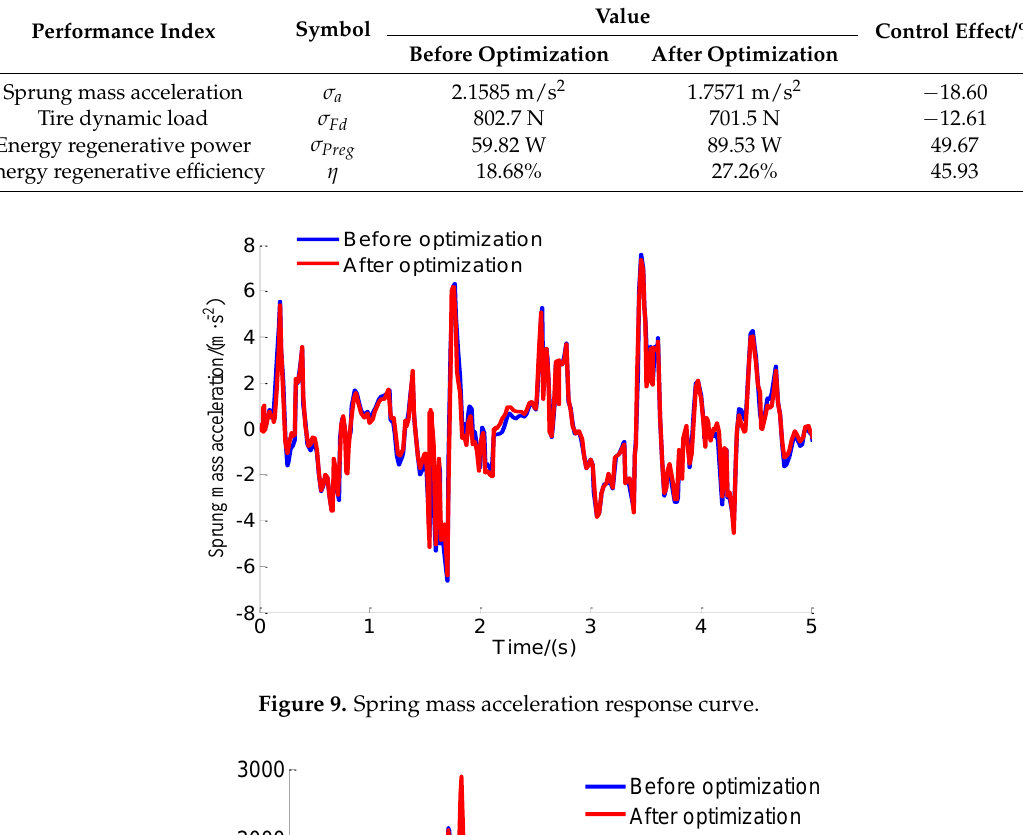
13 of 17 Table 1. Optimal parameters. Optimal Parameters